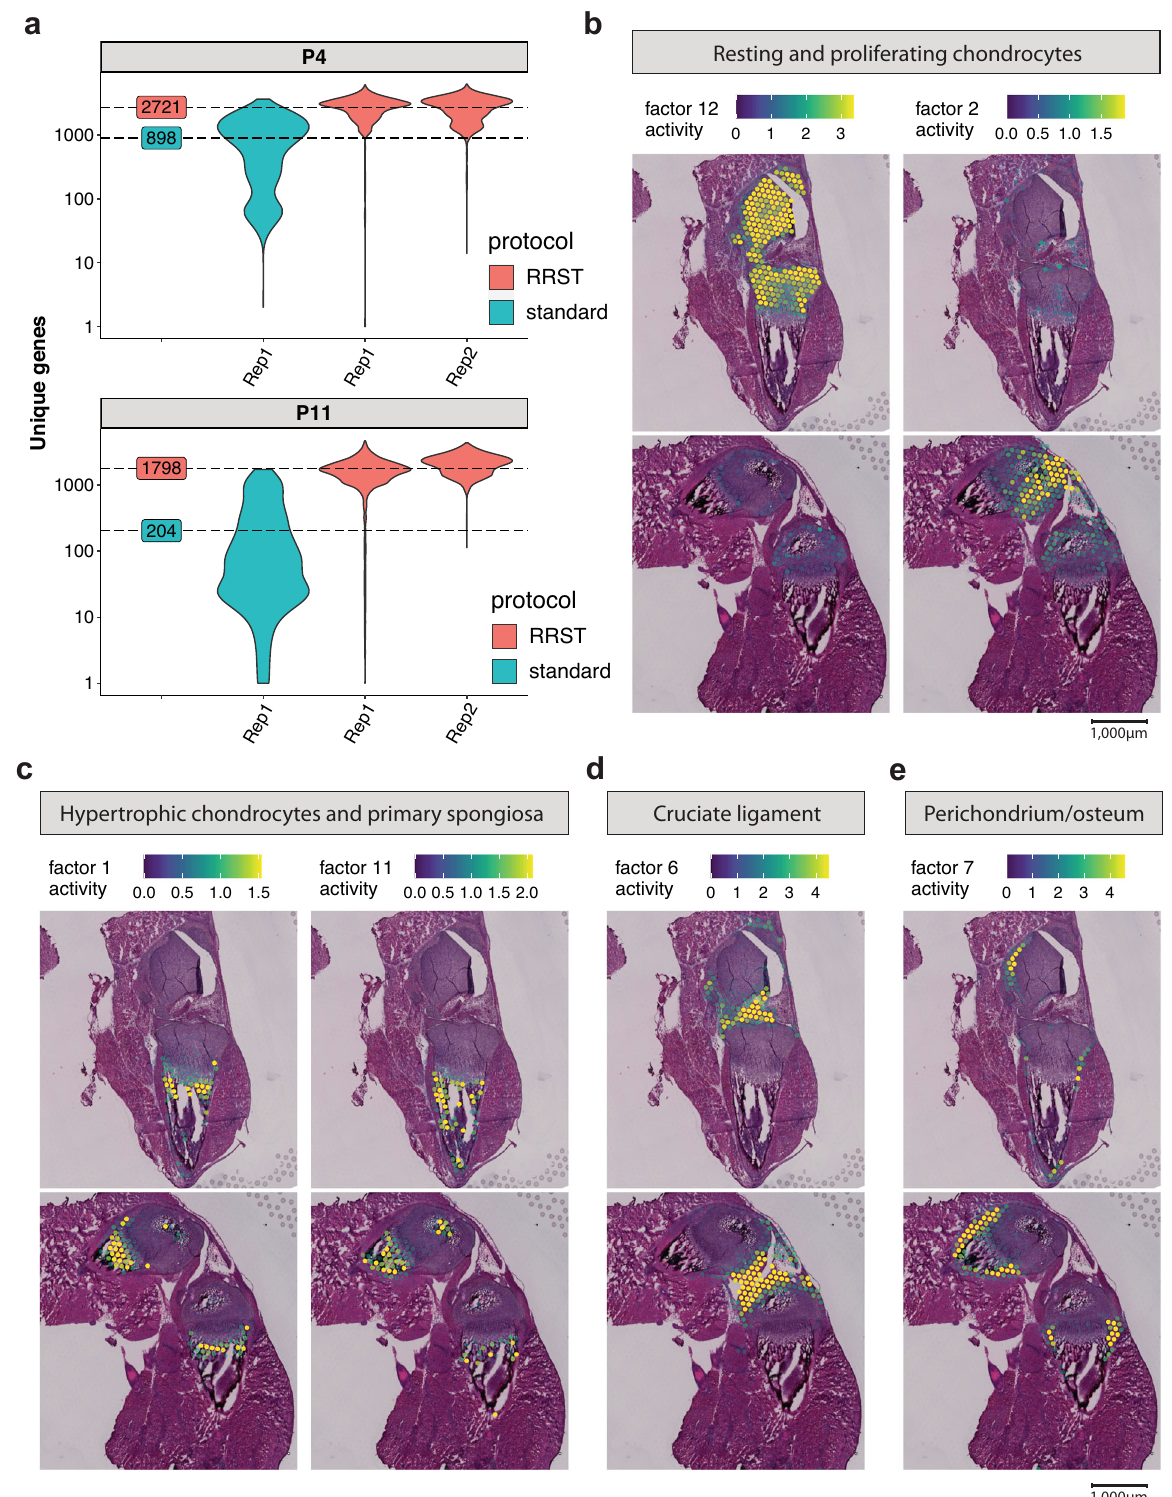
Fig. 6 | Comparison of standard Visium with RRST on mouse cartilage tissue. a Average numbers of unique genes are highlighted by dashed lines for each pro- tocol next to the violin plots. The y -axis represents log10-scaled counts. 1 tissue section was processed with the standard Visium protocol for P4 and P11, and 2 tissue sections for each timepoint (P4, P11) with the RRST protocol. b Following NNMF, Factors 12 and 2 associated with resting and proliferating chondrocytes.